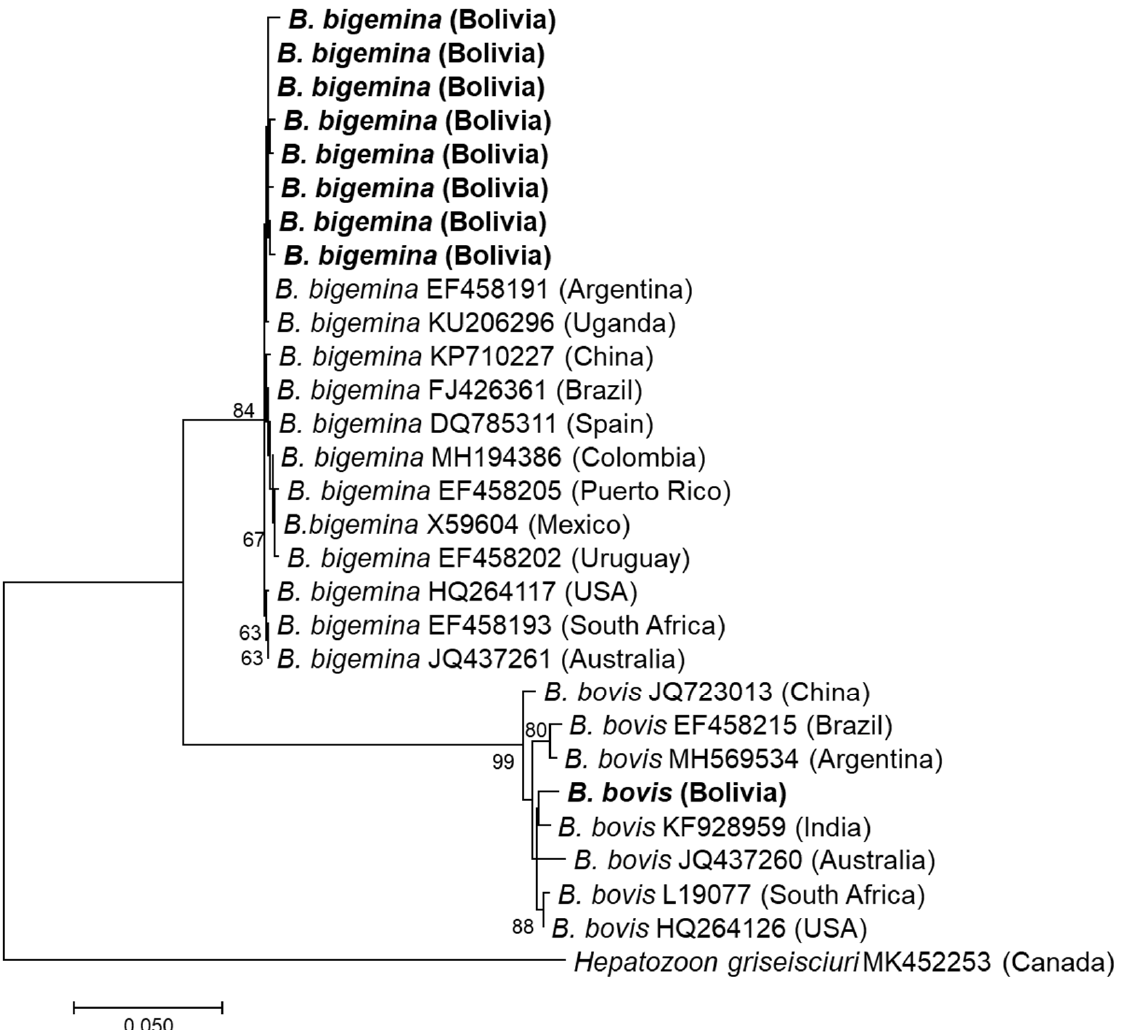
Figure 2. Phylogenetic tree based on 18S rDNA sequences of Babesia species. The phylogenetic tree was constructed using MEGA7 based on the maximum likelihood method using the Tamura 3-parameter model. Only bootstrap values greater than 60% are indicated. The sequences obtained in this study are shown in bold. The geographic origin (country) of each sequence/strain is provided in parentheses.